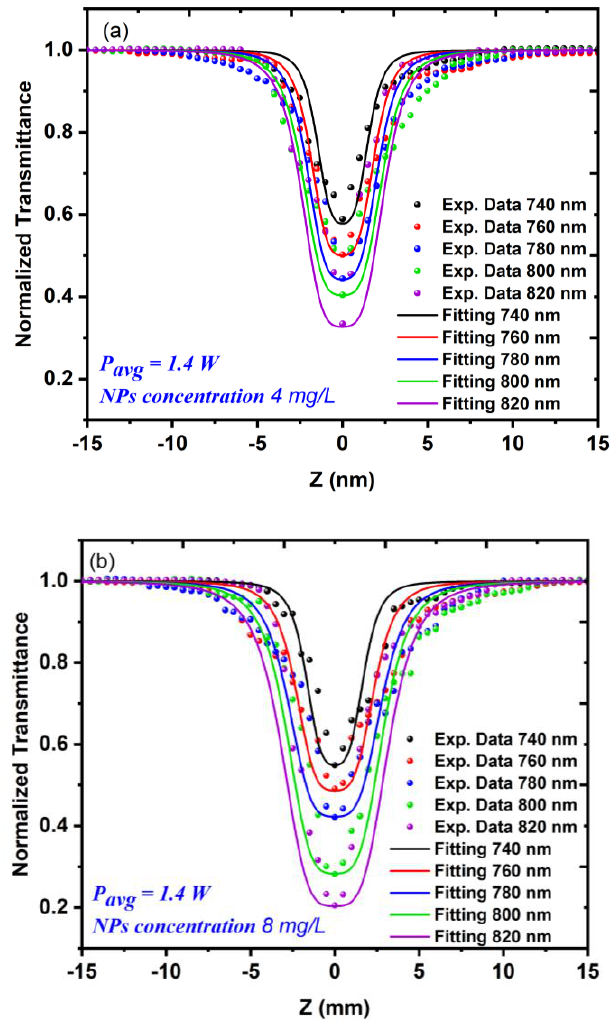
Figure 7. The OA z-scan measurements for the Au NP samples using different excitation wavelengths, which ranged from 740 to 820 nm at a constant average power of 1.4 W: ( a ) a sample concentration of 4 mg/L; ( b ) a sample concentration of 8 mg/L.